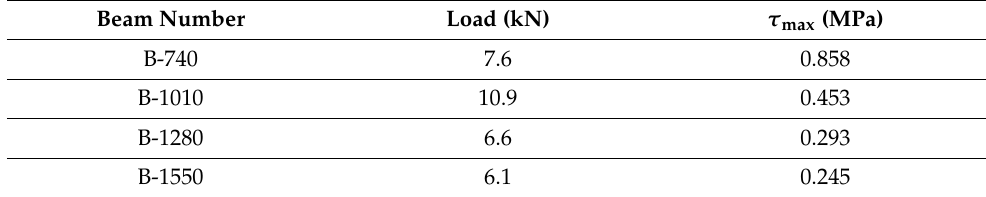
Table 6. Maximum shear stress of each beam.